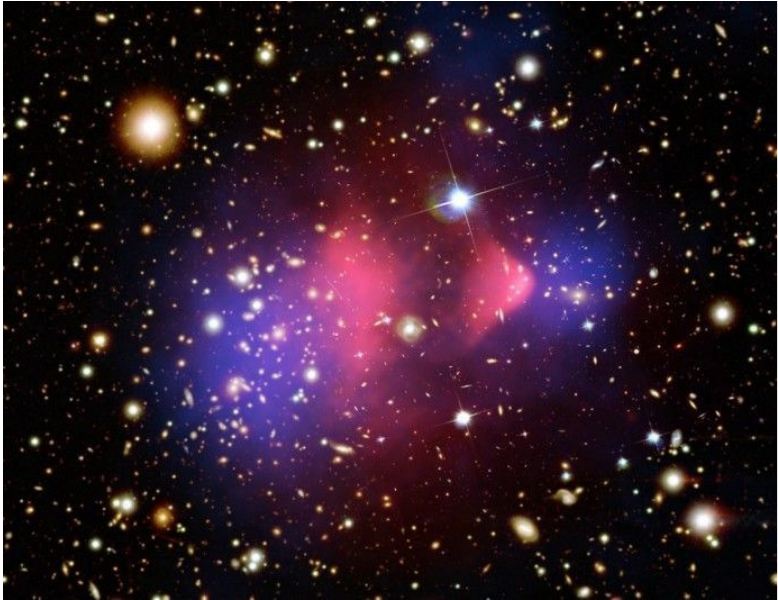
Figure 1. κ -map (blue) superimposed on the gas (pink) for the Bullet Cluster. The blue regions are the regions with the largest amount of gravity and are where dark matter is said to be concentrated when viewed in the Einsteinian paradigm; the red region is the visible mass obtained from X-ray observations. This image is a Chandra X-ray Observatory